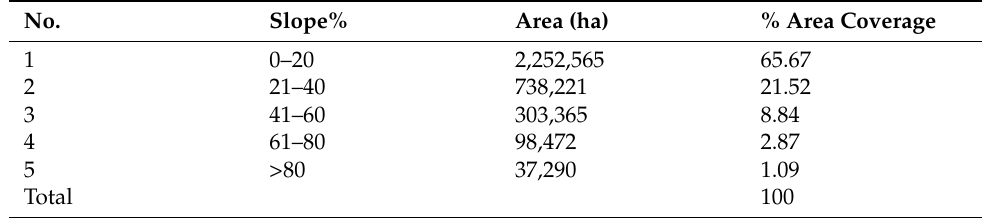
Table 2. Slope distribution in the Gomal River